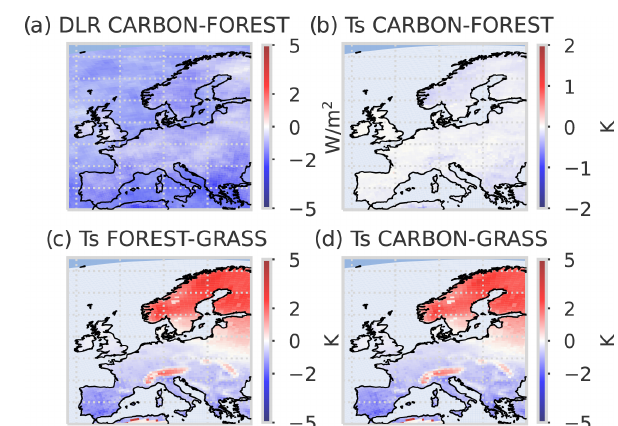
Figure 2. Yearly mean differences in (a) DLR between CARBON and FOREST, (b) T s between CARBON and FOREST, (c) T s be- tween FOREST and GRASS, and (d) T s between CARBON and GRASS for the period 1986–2015.